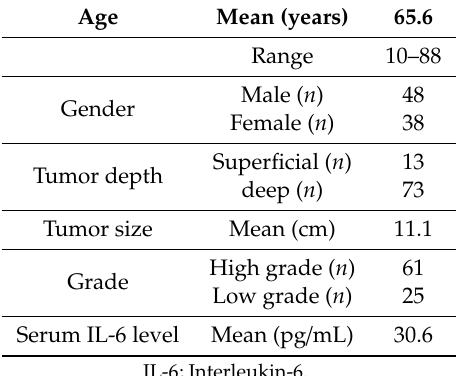
Table 1. The demographics of the 86 patients with soft tissue